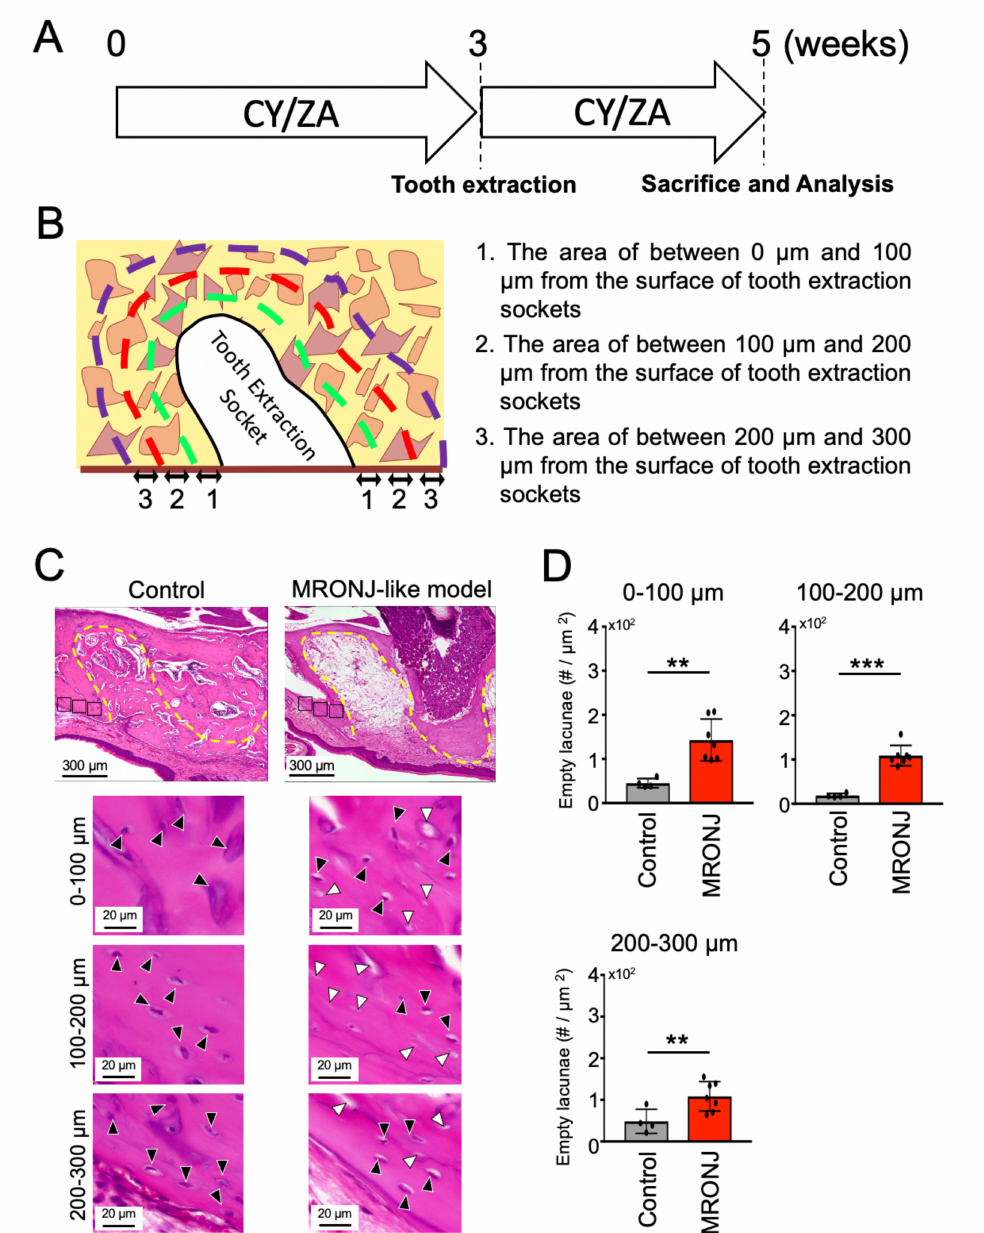
Figure 2. Effect of CY/ZA administration on the alveolar bone around the tooth extraction socket after two weeks of tooth extraction. ( A ) Experimental design: CY/ZA were administered for three weeks and continued for two weeks after extraction of the maxillary first molar. CY: cyclophosphamide, ZA: zoledronate. ( B ) Graphic image of the selected bone areas around the tooth extraction socket. Green, Red and purple lines represent the areas at 0 µ m to 100 µ m, 100 µ m to 200 µ m and 200 µ m to 300 µ m from the surface of the tooth socket, respectively. ( C ) HE-stained sagittal images of the bone surrounding the tooth extraction socket of control and MRONJ-like model (CY/ZA administration). Yellow line indicates the tooth extraction socket. Black and white arrowheads represent lacunae with and without cells in the bone, respectively. ( D ) The graph represents the quantitative analysis of empty lacunae in the bone surrounding the tooth extraction socket. The number of empty lacunae was significantly increased in the experimental group compared to that in the control group. The bars represent the mean ± standard deviation. *** p < 0.001, ** p < 0.01. unpaired Students’ t -test. n =